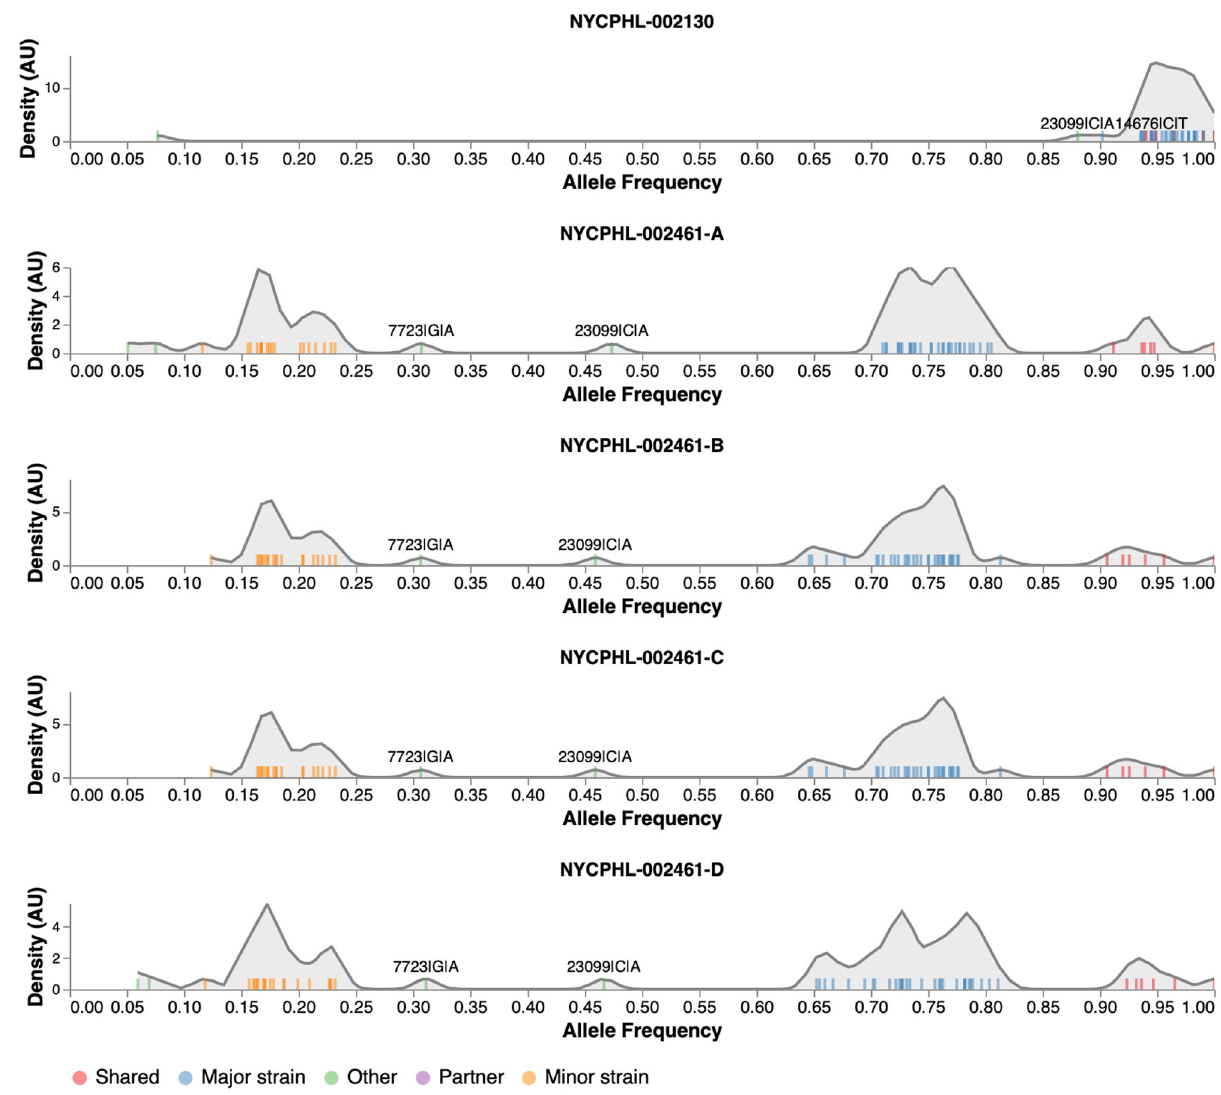
Fig. 1 The distribution of allelic frequencies in the index case (NYCPHL-002130) and named partner with suspected superinfection (NYCPHL- 002461). Frequencies of individual alleles shown as ticks, a smoothed kernel density plot is used to highlight clustering patterns, and colors represent allele